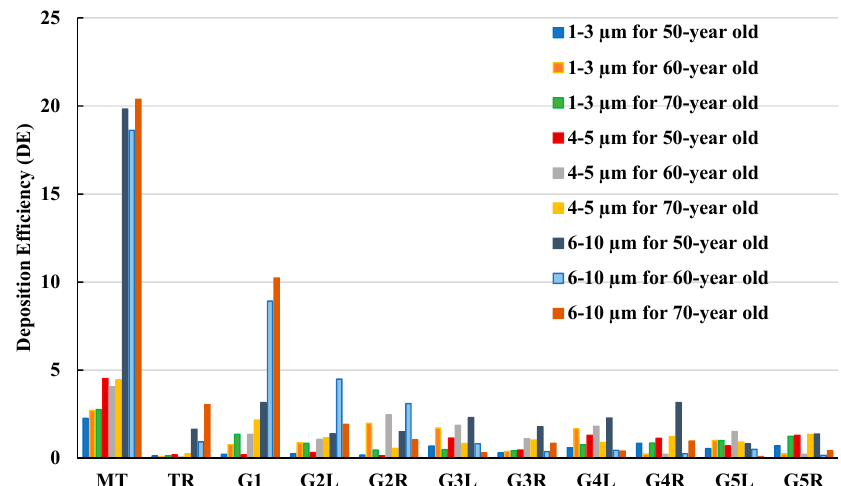
Figure 11. DE for different particle sizes at 60 L/m flow rate. MT, mouth-throat; TR, trachea; G1, Generation 1; G2L, Generation 2-left lung; G2R, Generation 2-right lung; G3L, Generation 3-left lung; G3R, Generation 3-right lung; G4L, Generation 4-left lung; G4R, Generation 4-right lung; G5L, Generation 5-left lung; and G5R, Generation 5-right lung. Int. J. Environ. Res. Public Health 2021 , 18 , x